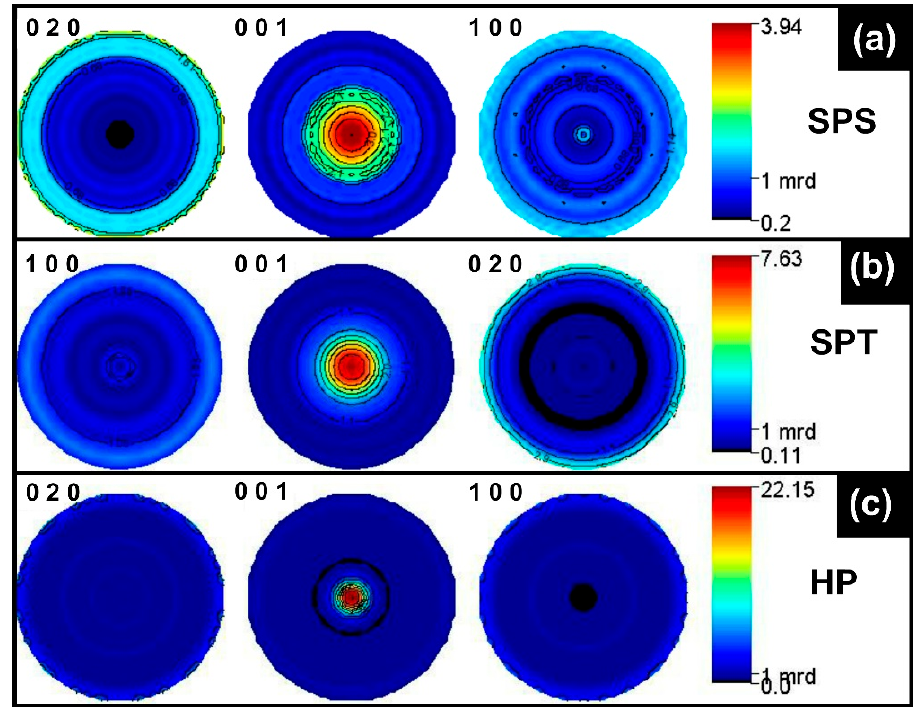
Figure 3. {100}, {001}, and {010} pole figures achieved after the combined refinement of the orientation distribution function (ODF) for the ( a ) SPS, ( b ) SPT, and ( c ) HP samples.